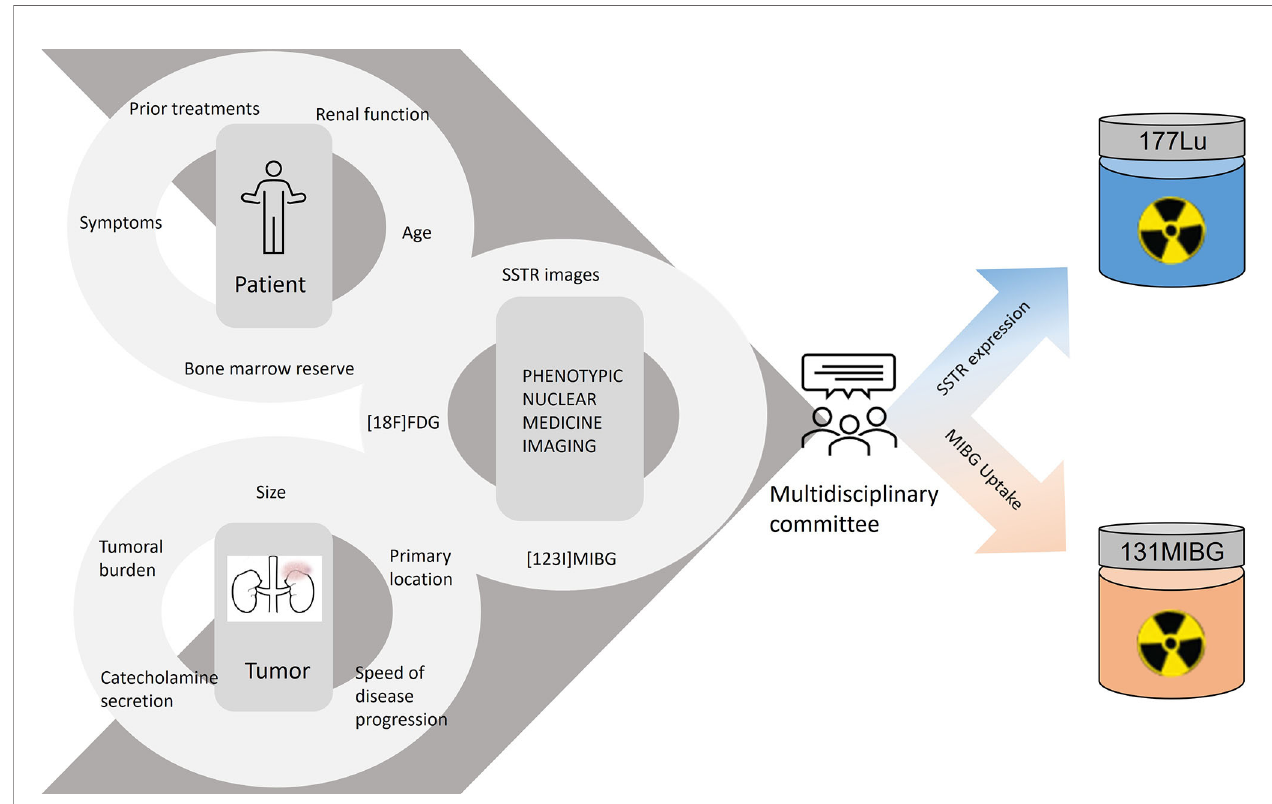
FIGURE 2 | Therapeutic decision work fl ow.